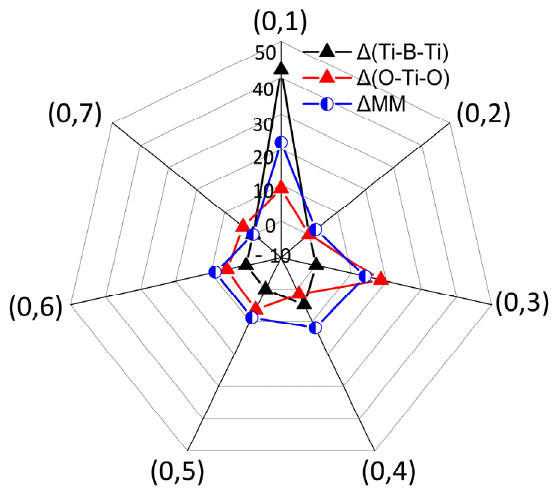
∆ MM. Remarkable bending of the O-Ti-O bond angles and ∆ MM are visible in the (0,3) configuration. ◦ ◦ The slightly 4.5 bent Ti-B-Ti unit and 1.7 bent O-Ti-O unit in the (0,4) structure with respect to the ◦ fixed Ti-B-Ti unit and the 18.5 bent O-Ti-O unit in the (0,3) structure trigger ∆ MM values of 12.01 µ B and 13.97 µ B for the two configurations respectively, which indicates that the magnetism in di ff erent (0,j) configurations is theoretically associated with their structures, e.g., correlated with the bending of Ti-B-Ti and O-Ti-O units.